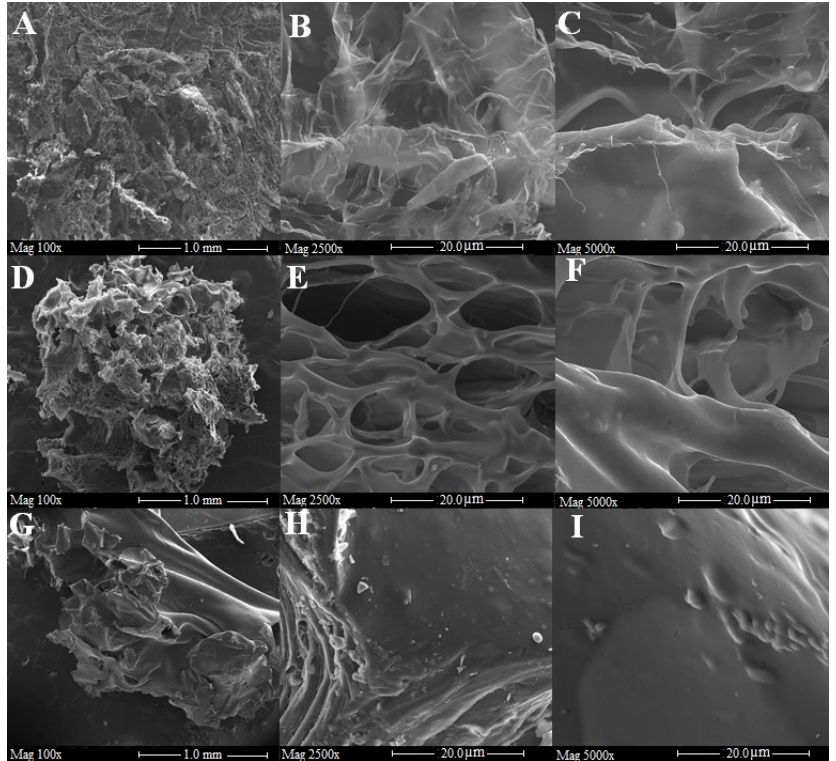
Figure 2. Scanning electron images of PJ1 ( A – C ), PJ2 ( D – F ), and PJ3 ( G – I ). The magnification